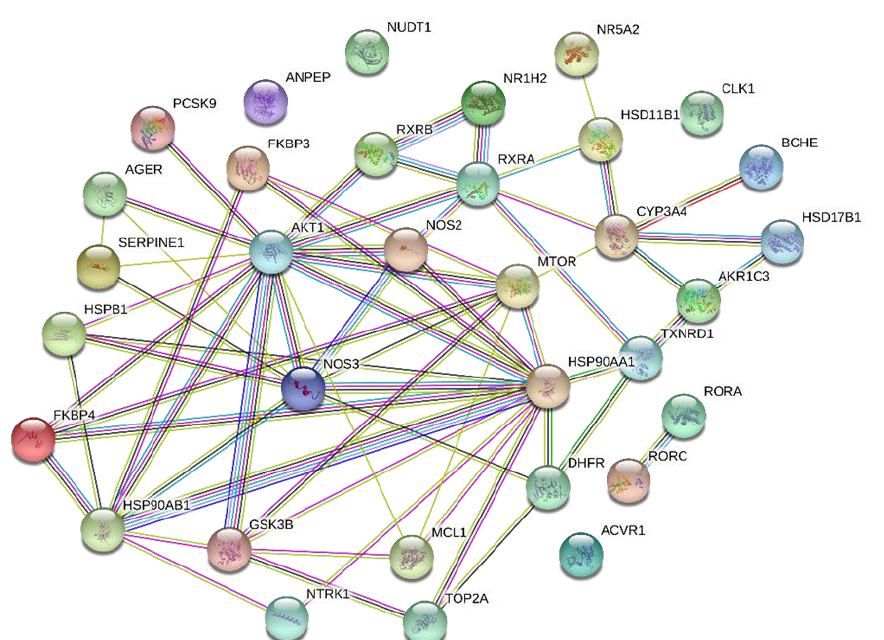
Figure 3. Predicted protein interaction network for complexes with 5-oxocoronaridine alkaloid (PPI enrichment p -value: 3.45 × 10 − 12 ). Edges represent the evidence of protein–protein associations. Nodes represent proteins with good binding affinity energies (lower than − 9.0 kcal/mol) with the molecule. The names of the proteins represented in each node and their respective acronyms can be found in Supplementary Material Table S3.